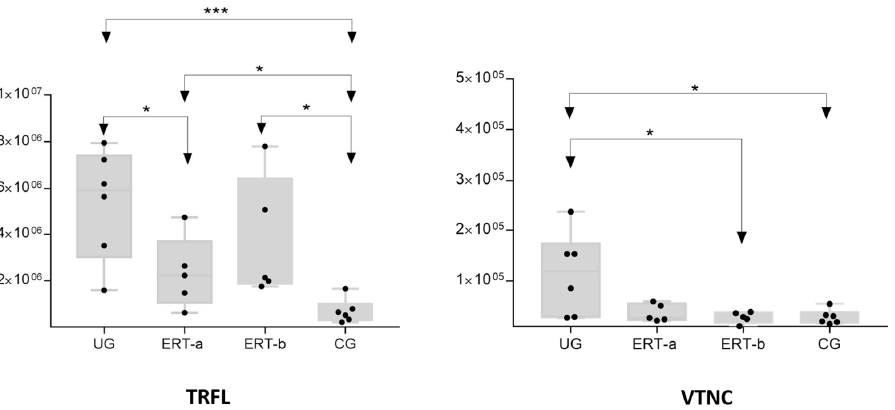
Figure 8. Variations in the levels of TRFL and VTNC proteins in the different groups analyzed. Each point represents the mean value of the protein area for an individual sample in each group. The bottom and top of each box represent the first and third quartiles, respectively. The whiskers represent the minimum and maximum values within 1.5 times the interquartile range. Any data points not included between the whiskers are considered outliers. * p < 0.05; ** p < 0.01; *** p < 0.001. Abbreviations: CG, control group; ERT-a: ERT-a, patients sampled before enzyme infusion; ERT-b, patients sampled 24 h after enzyme infusion; TRFL, lactotransferrin; UG: untreated group; VTNC, vitronectin.